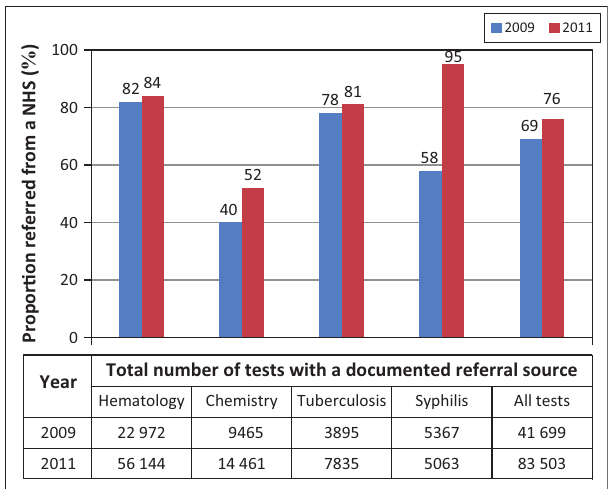
FIGURE 3: Proportion of tests referred from non-HIV services in 2009 and 2011 from amongst tests with a documented referral source. After excluding tests without a documented referral source, a total of 51 laboratories in 2009 and 61 laboratories in 2011 remained for the analysis. The total number of tests for which any referral status was available is shown for each year below the graph for each test